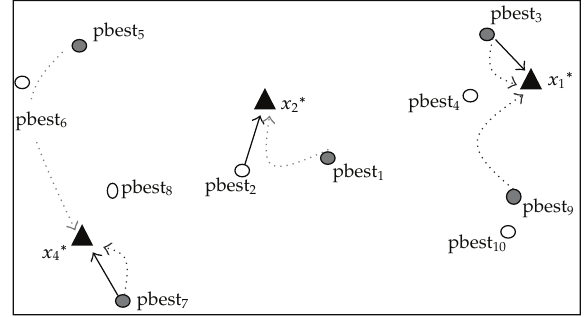
Figure 2: Illustration of local search phase for a population with 10